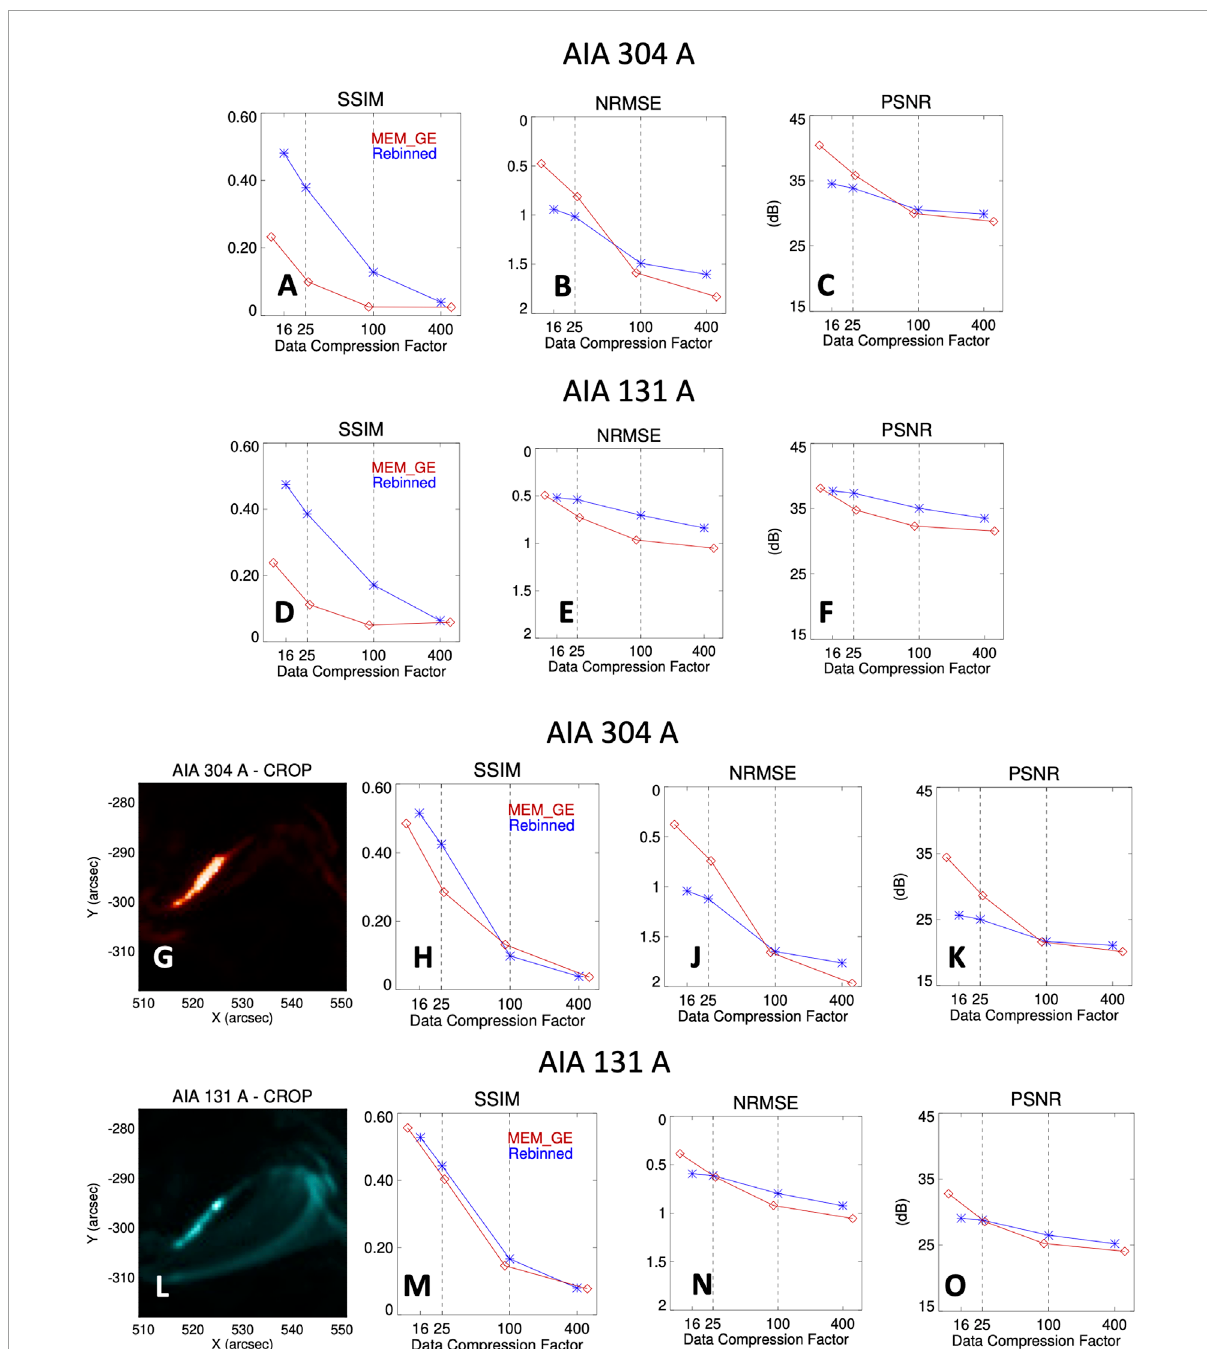
FIGURE 8 SSIM, NRMSE, and PSNR metrics associated with the MEM_GE reconstructions (red) and the spatially rebinned images (blue) for different data compression factors. Panels (A) through (C) show the metrics for the AIA 304 Å image shown in Figure 1 , while panels (D) through (F) show the same information for the AIA 131 Å image. Panels (H) through (K) , and (M) through (O) , are analogous to Panels (A) through (C) , and (D) through (F) , respectively. However, in this case, the metrics are computed with respect to a cropped 70-pixel × 70-pixel subregion of the original images, as shown in panels (G) and (L) . A logarithmic scaling has been applied to the x -axis of each metrics panel; in addition, in order that “better” be represented by a point nearer the top of each panel, the y axes of panels (B) , (E) , (J) , and (N) , representing the NRMSE metric, have been reversed. The vertical lines at DCF ≃ 25 and 100 in each panel represent the data compression factors corresponding to the rebinned images shown in Figure 2 . The DCF values adopted for the MEM_GE reconstructions are slightly different from those of the rebinned images, as shown by the small horizontal shifts between the red and blue